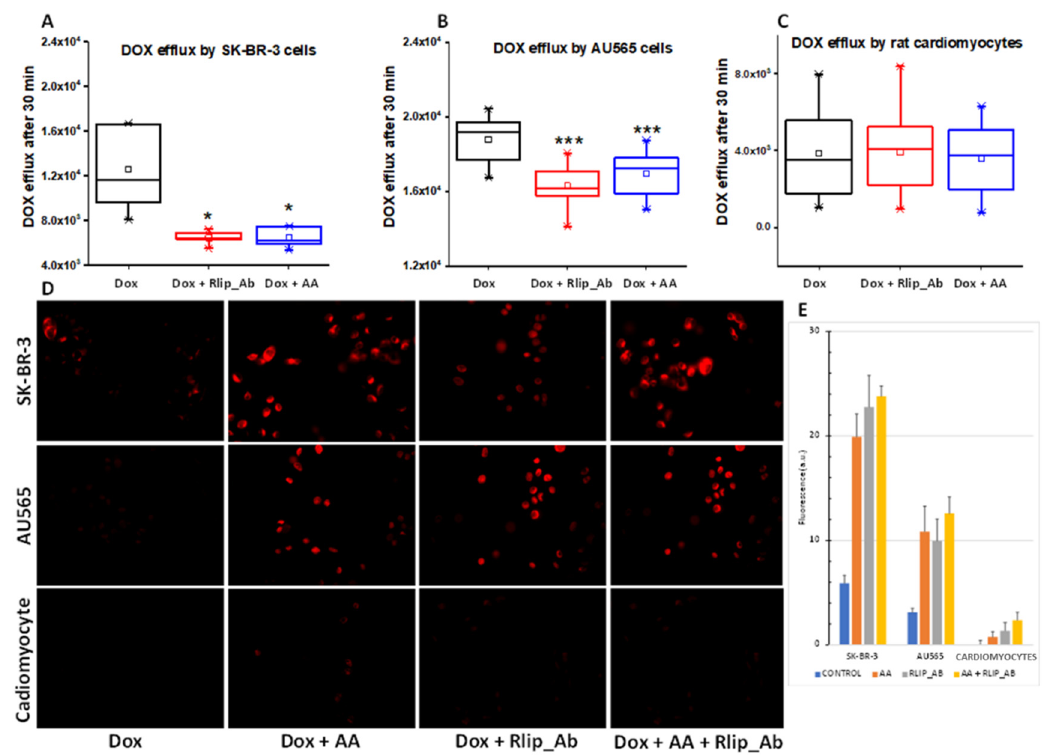
Figure 10. ( A – E ) Doxorubicin efflux after AA in SK-BR-3 and AU565 cells and H9C2 cardiomy- ocytes. The assay was performed as described in Materials and Methods. (A) Box and whisker plots show dox effluxed into growth medium. Following a 30 min dox exposure and a 1 h ex- posure to Rlip antibody or 150 µM AA, efflux was measured by timed sampling of the medium over 30 min. Data presented here are representative of three independent experiments. * p < 0.05, *** p < 0.001, as compared to dox alone. Box: 25–75 percentiles; whiskers: 1.5 IQR; horizontal inner line: median; small square: mean. The significance of differences among groups was evaluated using one-way analysis of variance (ANOVA) with a post hoc Tukey–Kramer test. All images are at 400 × magnification. Histograms show quantitated fluorescence intensity as measured by Image J.